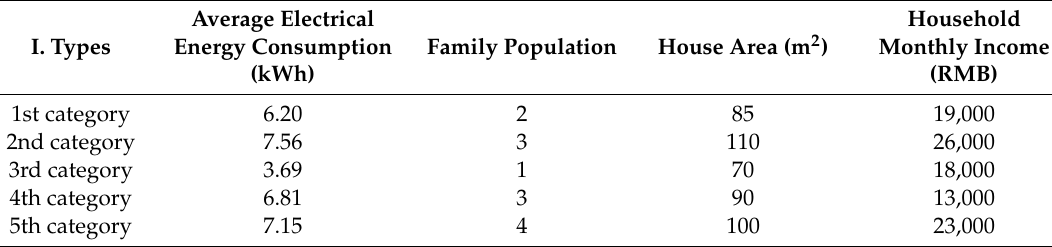
Table 2. User characteristics of each type in the clustering result.